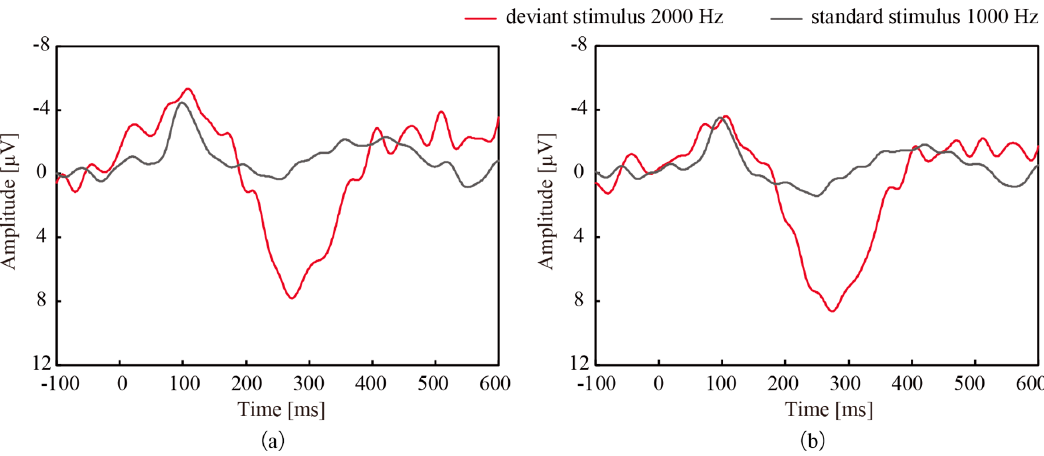
Figure 5. The amplitudes of EEG ( a ) 307 ms after the deviant and standard stimuli with CMEs and ( b ) 305 ms after the stimuli with wet electrodes. A significant difference was found between the response to deviant and standard stimuli. Error bars: standard deviation.